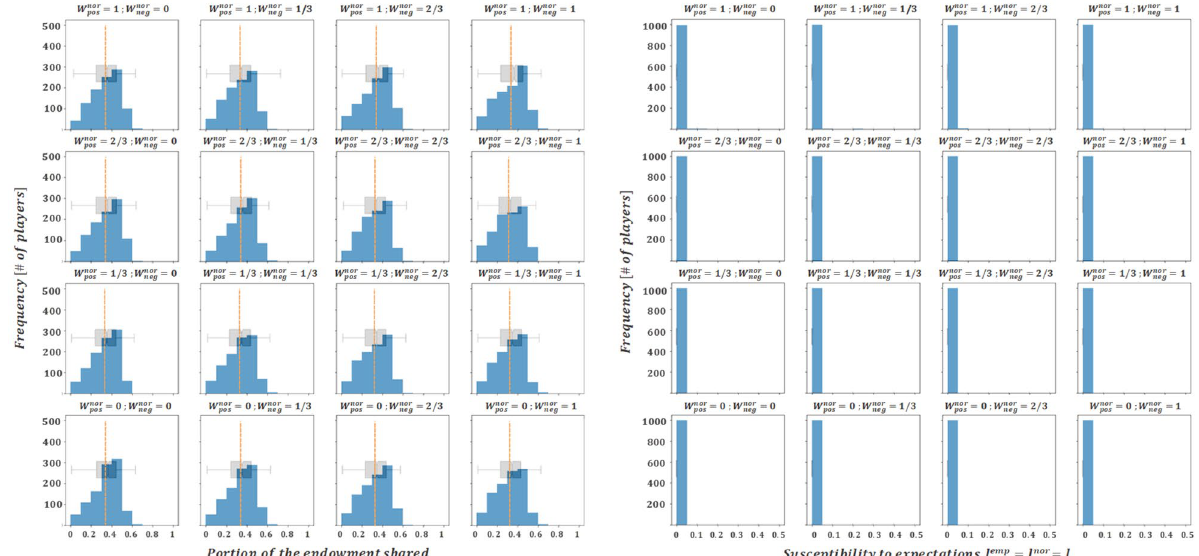
Figure 4. Final averaged distributions of donations (left) and susceptibility profiles emp W emp = 1 . Each subplot represents results for the scenarios of with l nor i , t = l i , t (right) for W nor , pos ( whichvariesacrossrows ) and W nor , neg ( whichvariesacrosscolumns ) assumed in B